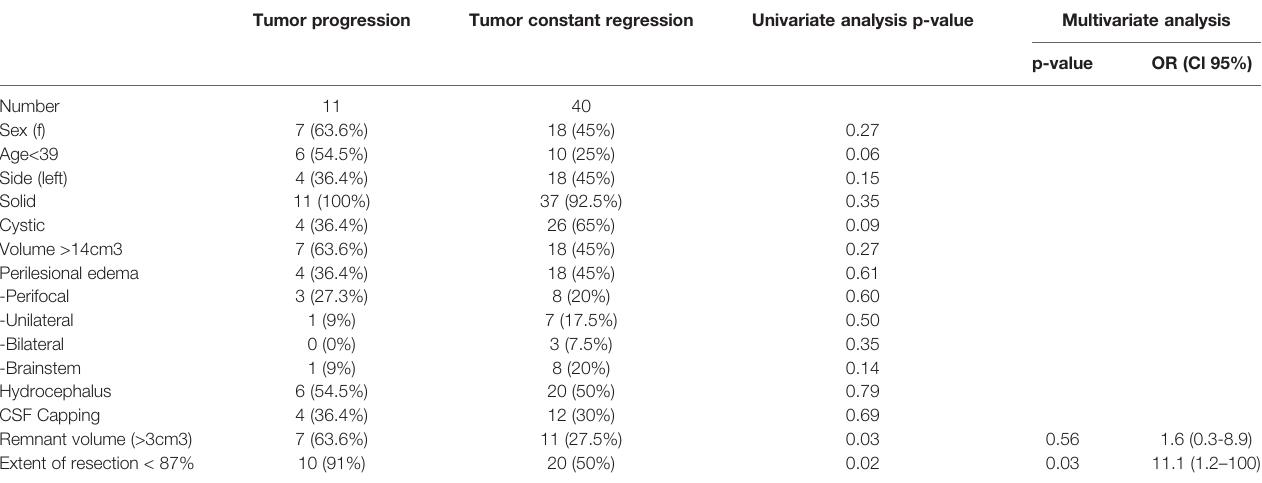
TABLE 4 | Predictors for remnant